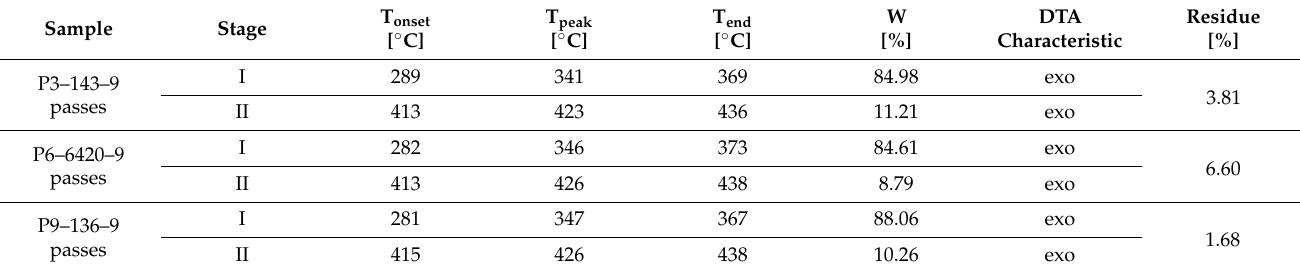
Table 4. Thermogravimetric characteristics of the samples covered with ceramic